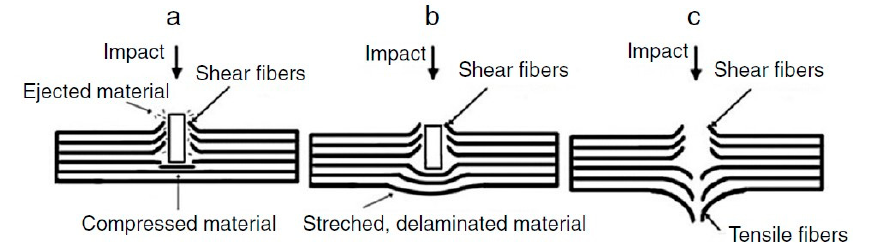
Figure 20. Ballistic failure mechanism proposed after the impact: ( a , b ) partial penetration and ( c ) complete perforation. (Adapted with copyright permission from Silva et al. [142] ).